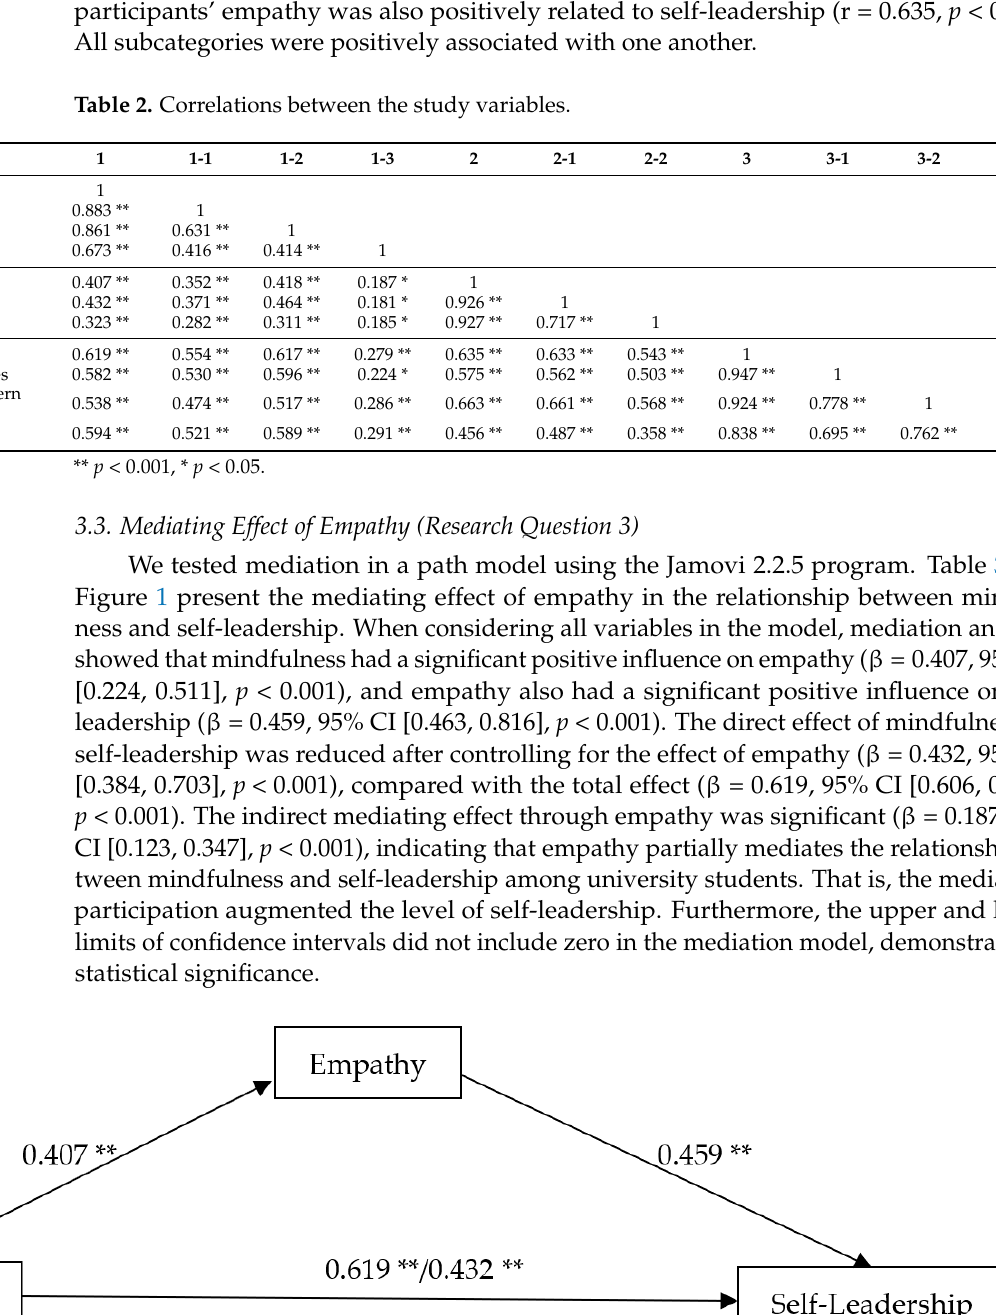
Figure 1. Mediation model of the effect of empathy between mindfulness and self-leadership; ** p < 0.001.